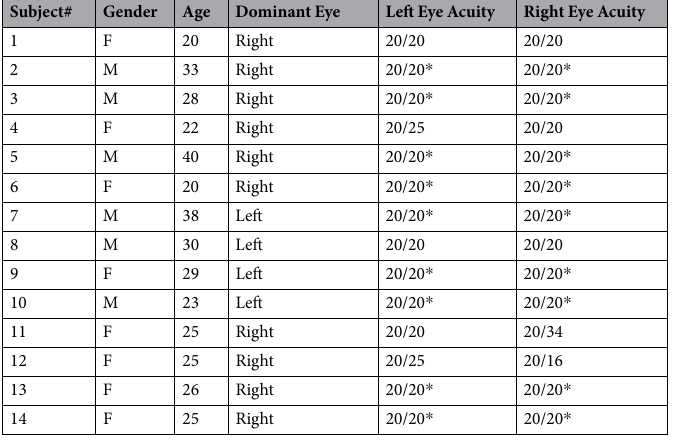
Table 1. Information of subjects participating in the experiment. Acuities marked with an asterisk are for subjects who wore optical correction during the